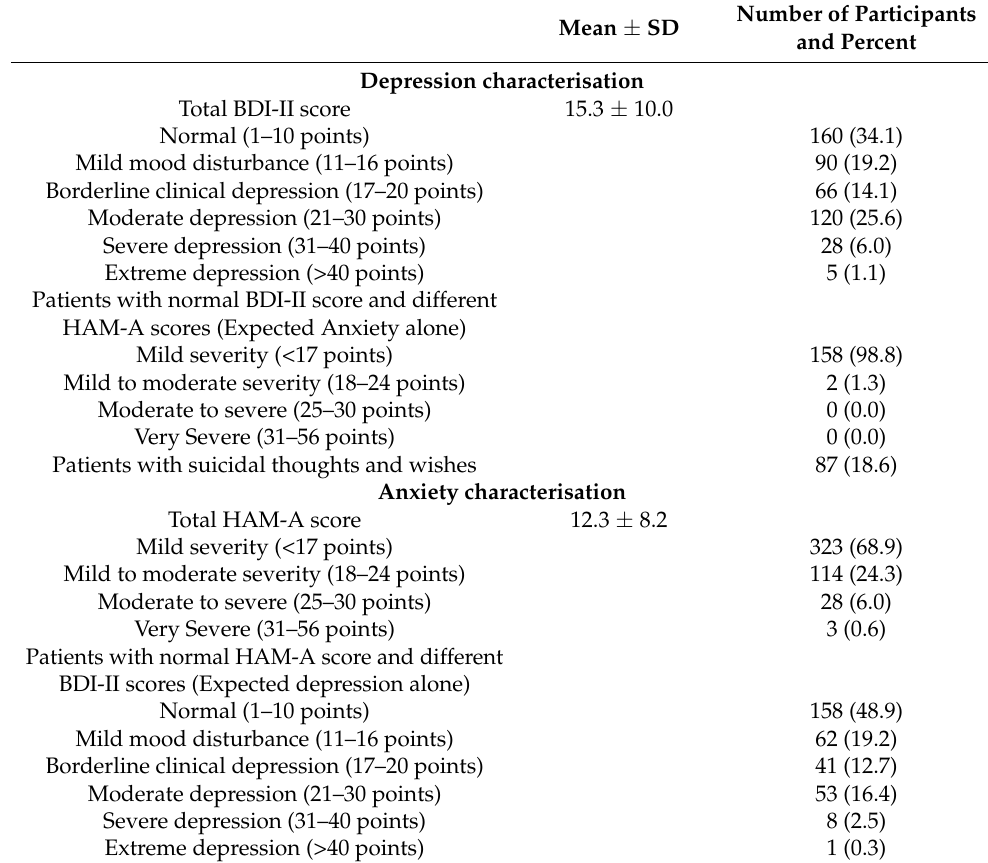
Table 2. Summary of BDI-II and HAM-A scores and grading ( N =